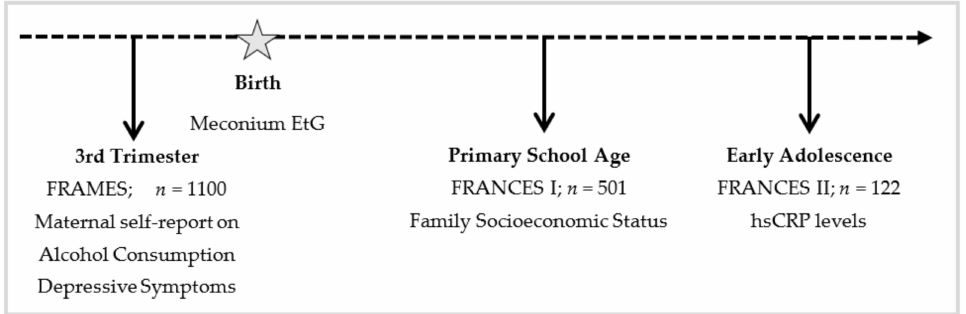
Figure 1. Timeline for Study